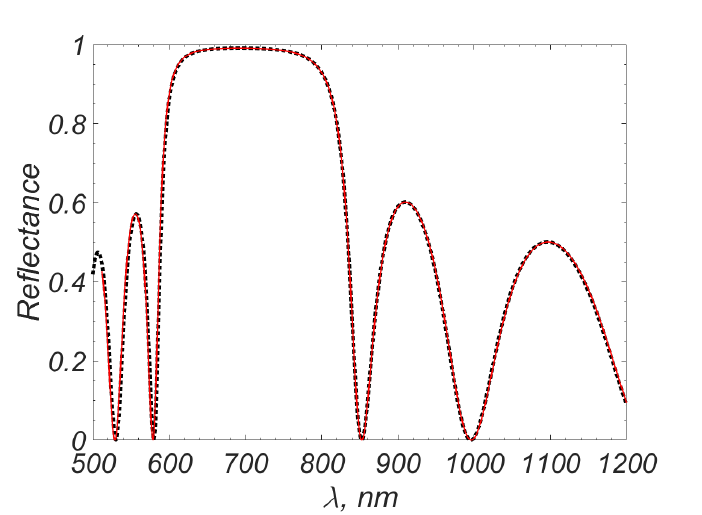
Figure 10. Photonic crystal from Figure 8. Reflection spectrum for the s -polarized wave. Solid line is the optical paths method and the bicompact scheme, N = 576; dotted line is the matrix